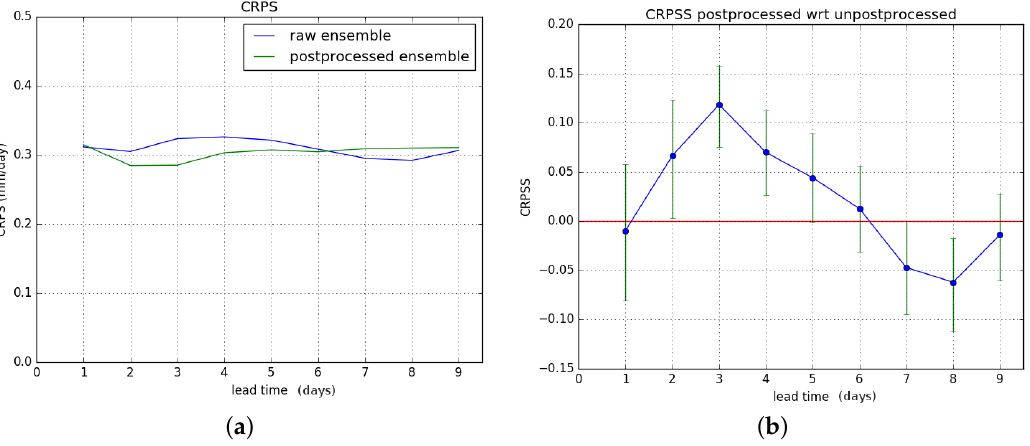
Figure 10. CRPS and CRPSS improvement for entire verification period. ( a ) CRPS comparison; ( b ) Improvement due to